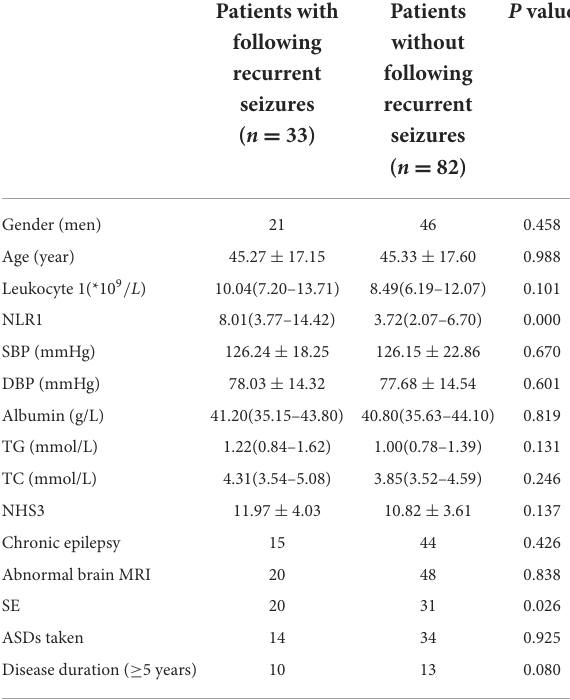
TABLE 5 Comparison of baseline characteristics between patients with and without following recurrent seizures after admission.